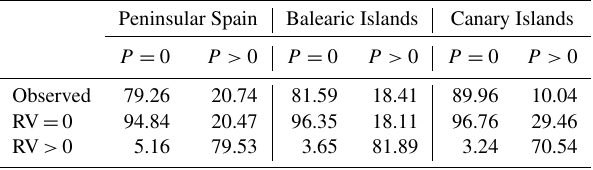
Table 3. Accuracy of the wet/dry day estimates: percent observed dry ( P = 0) and wet ( P > 0) days, and percent predicted dry (RV = 0) and wet (RV > 0) days on observed dry and wet days. Peninsular Spain Balearic Islands Canary